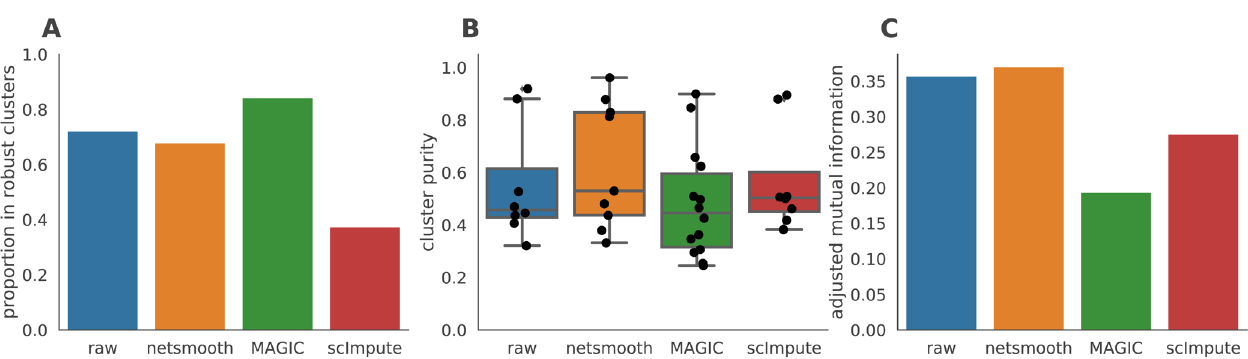
Figure 3. Hematopoiesis clustering metrics. A ) The proportion of cells which were assigned to robust clusters. B ) cluster purity (proportion of dominant cell type) for the robust clusters. netSmooth produces the most pure clusters in terms of cell types. C ) AMI of the clustering results obtained after application of each of the methods. Only netSmooth increases the AMI between the clustering and the cell types. The online version of this figure is interactive.